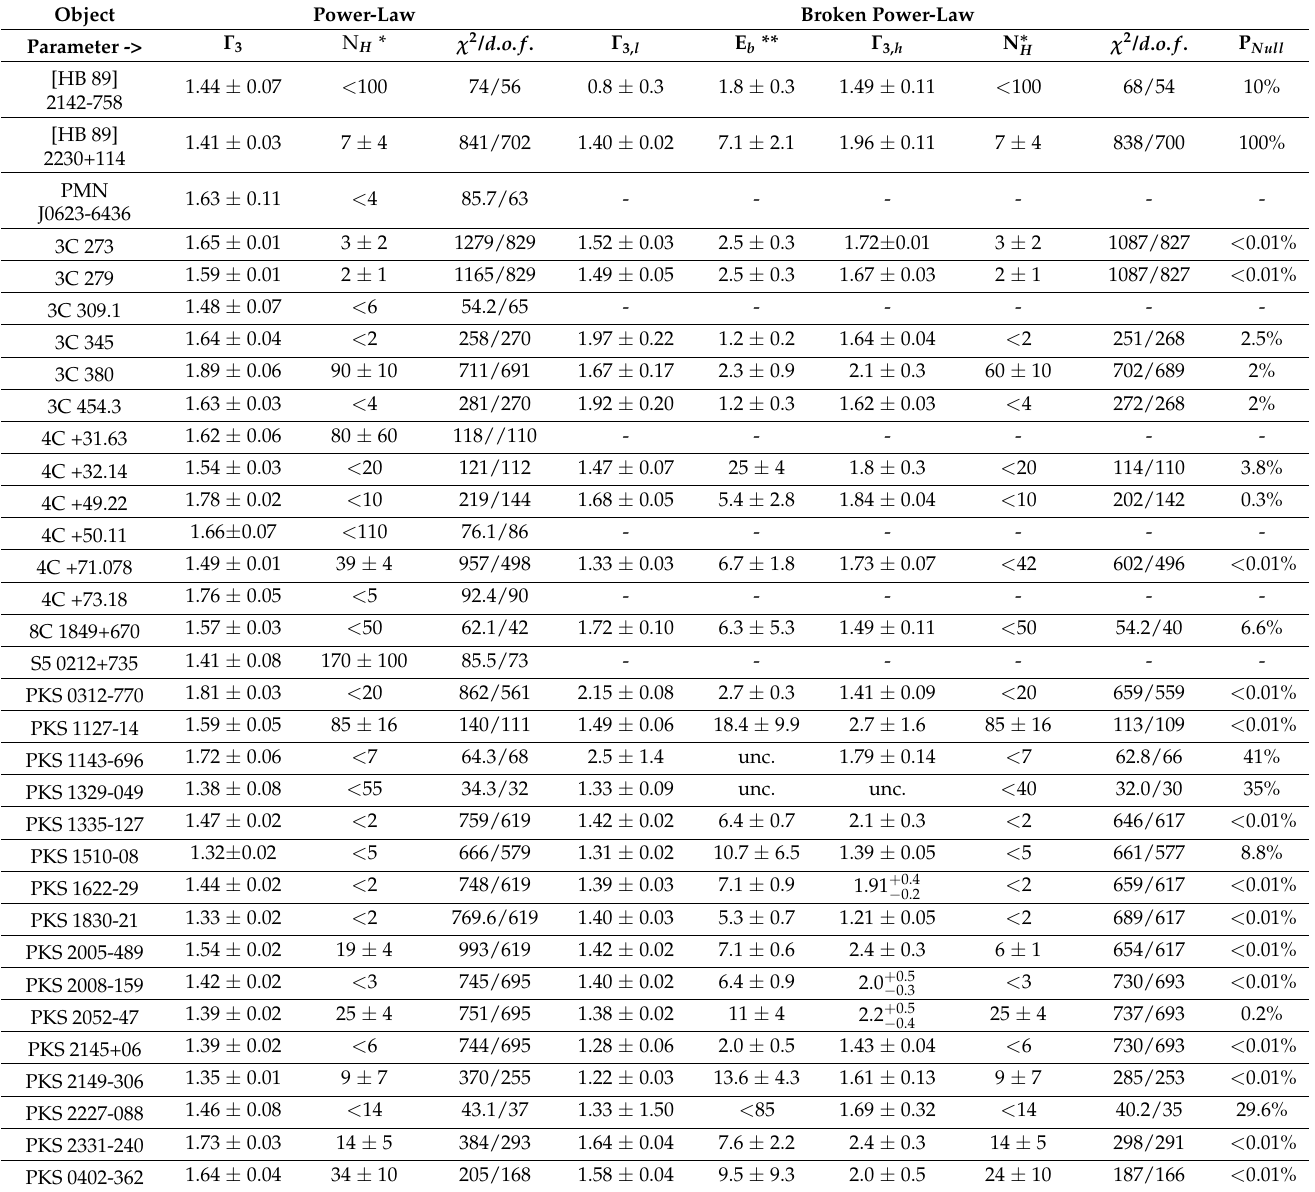
Table A2. The model parameters for the Swift